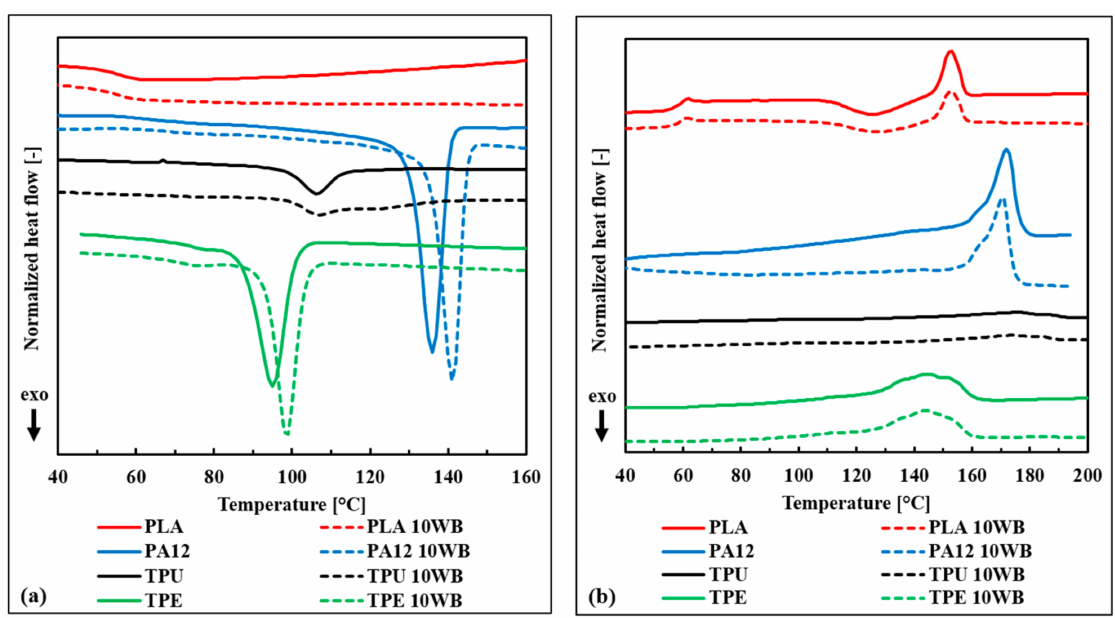
Figure 4. DSC curves of WB-based samples during ( a ) cooling and ( b ) the second heating